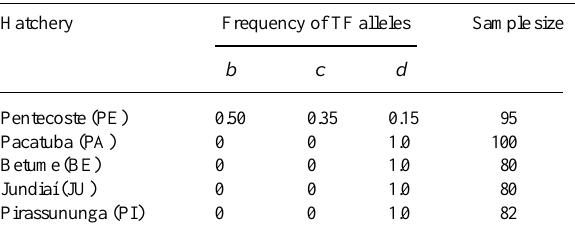
Table I - Frequency of transferrin alleles in five Brazilian tambaqui